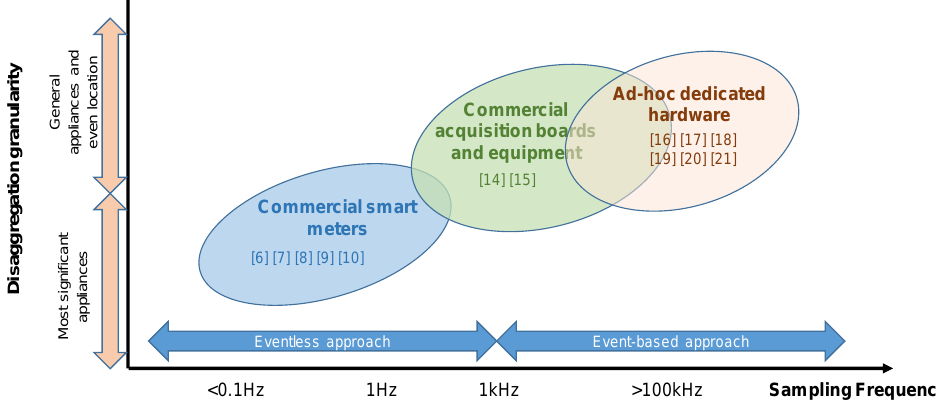
Figure 1. Data collection systems for NILM applications versus sampling frequency.